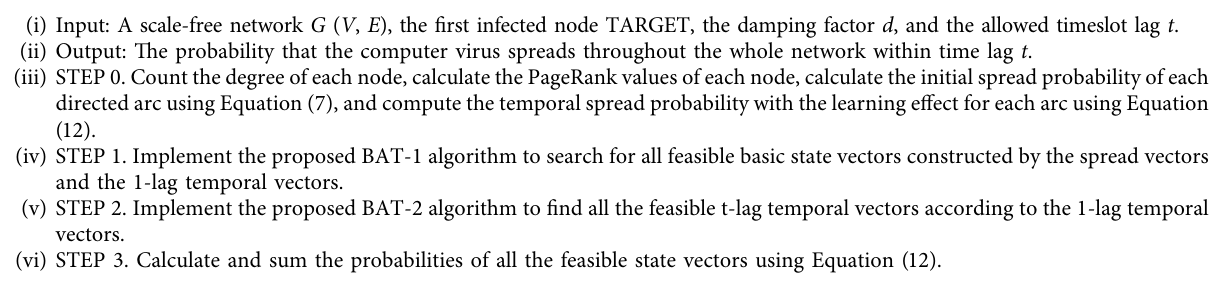
Table 15: Probabilities of the first 30 1-LAG temporal vectors based on Table 14.